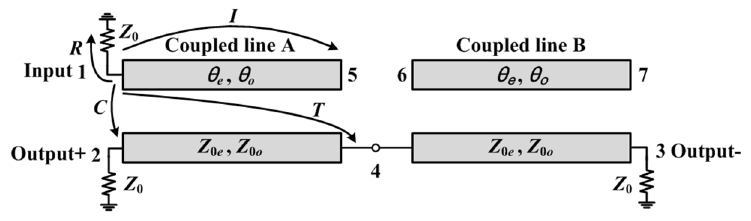
Figure 1. Schematic of the proposed frequency tunable balun.